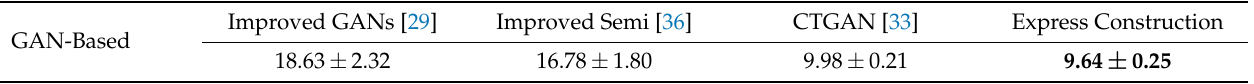
Table 3. The results of semi-supervised learning methods on the CIFAR-10 dataset. We compare the proposed method with others using the test error. The best score is marked in bold.